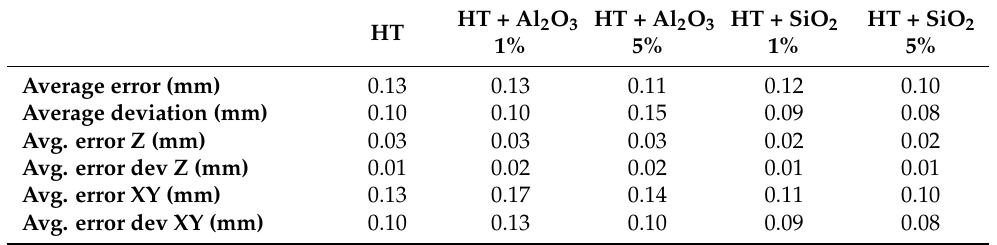
Table 4. Measurement analysis for inward features.